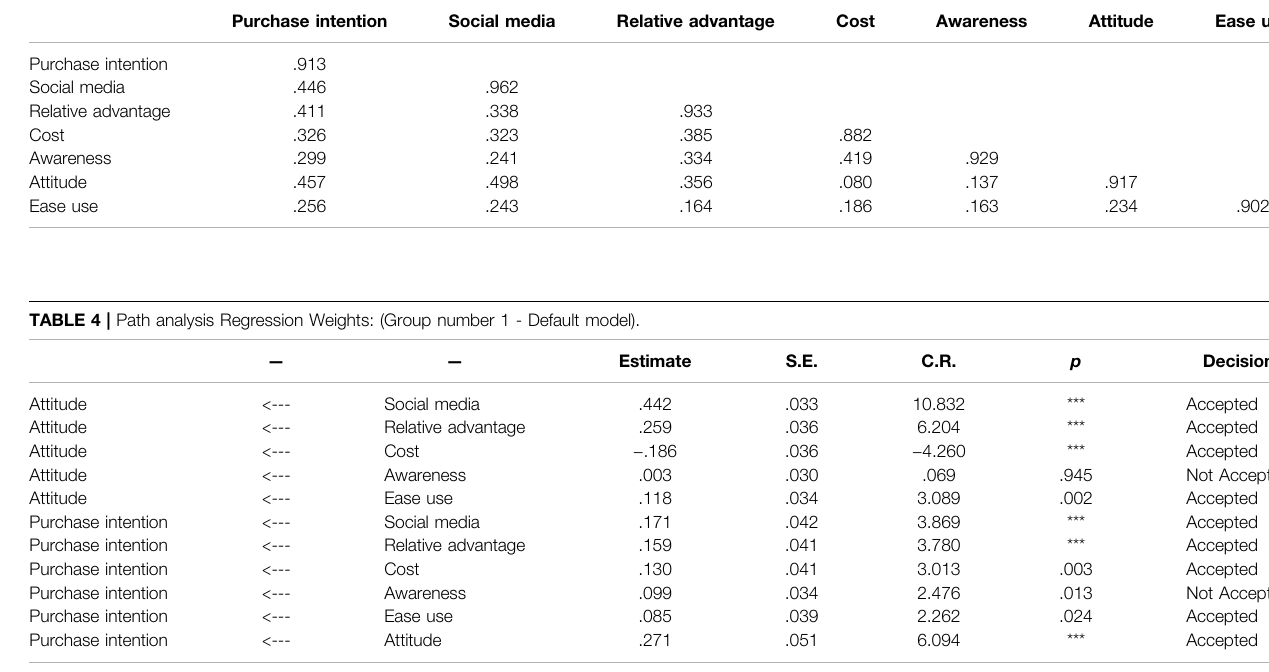
TABLE 3 | Discriminant validity of the constructs.